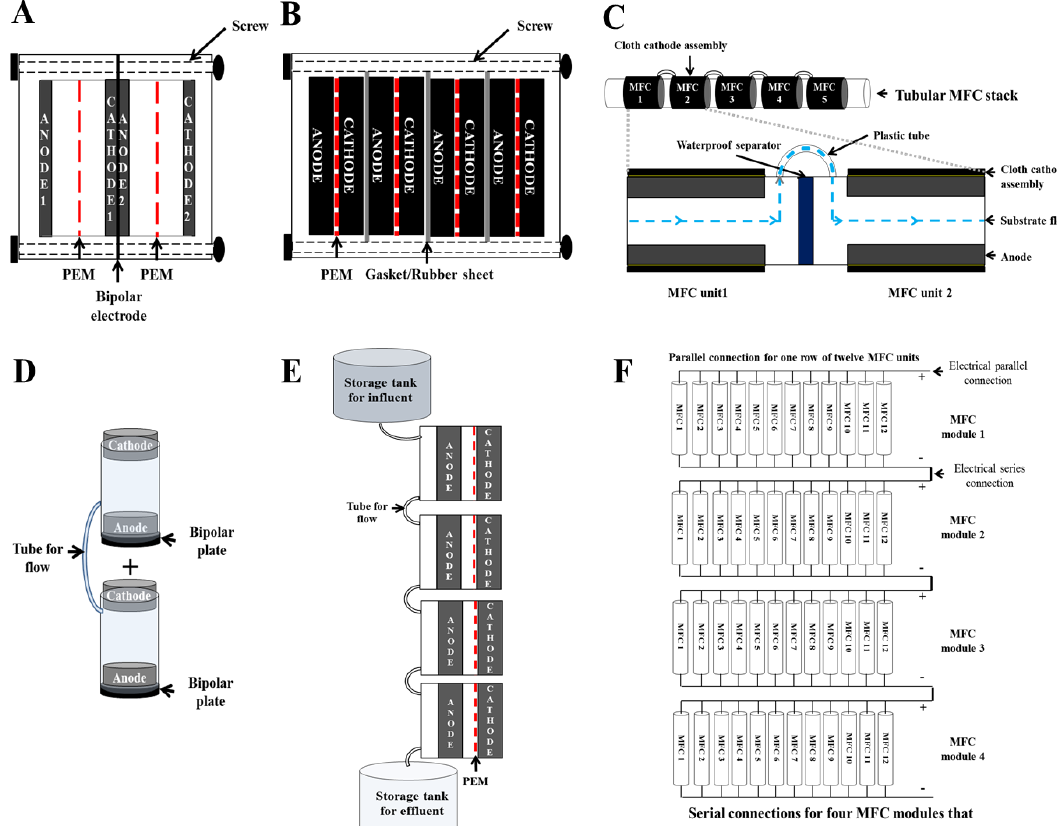
Figure 6. Schematic diagrams of stacked MFCs. ( A ) a bipolar plated, double-chambered MFC horizontal stack; ( B ) double-chambered MFC horizontal stack; ( C ) a tubular, air-cathode MFC horizontal stack; ( D ) a tubular, bipolar, plate membrane-less, double-chambered MFC vertical stack; ( E ) a cascade, air-cathode MFC vertical stack; and ( F ) a module MFC stack with both serial and parallel connections.